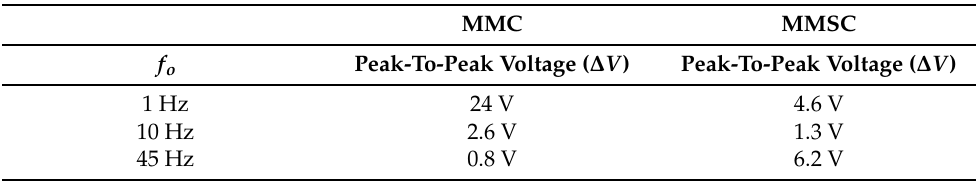
Table 5. MMC and MMSC submodule capacitor voltage